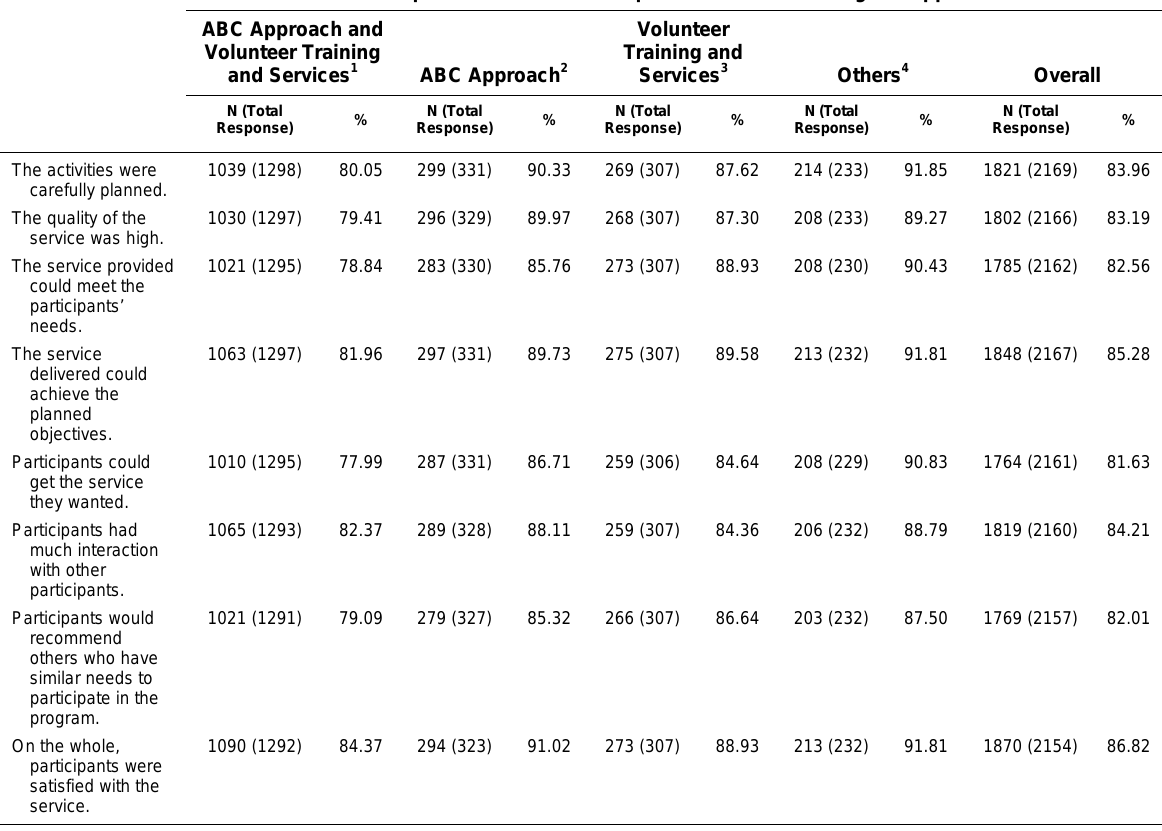
Comparison of the Positive Views Towards Tier 2 Program Among Different Program Approaches Participants with Positive Responses in Different Program